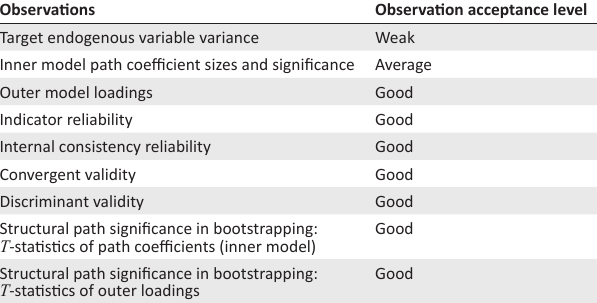
TABLE 5: Observation level of acceptance